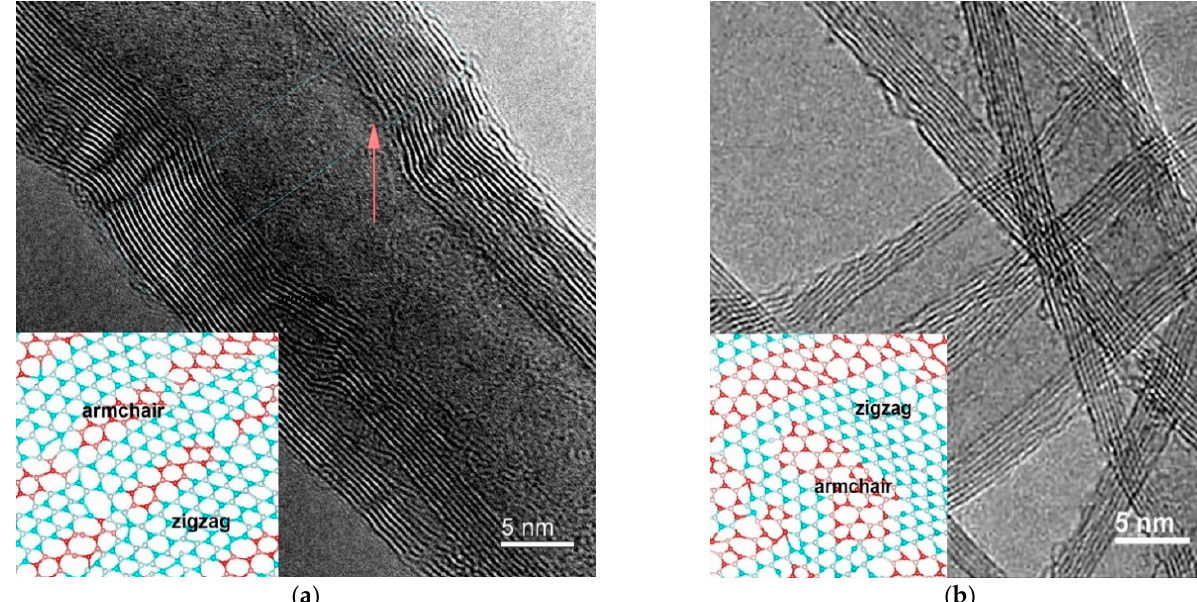
Figure 1. High-resolution TEM images of samples S1 ( а ) and S2 ( b ).